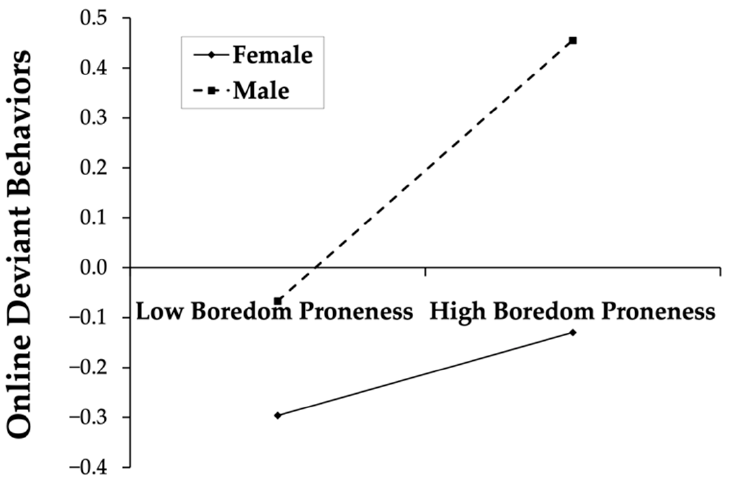
Figure 2. The association between boredom proneness and online deviant behaviors for gender.